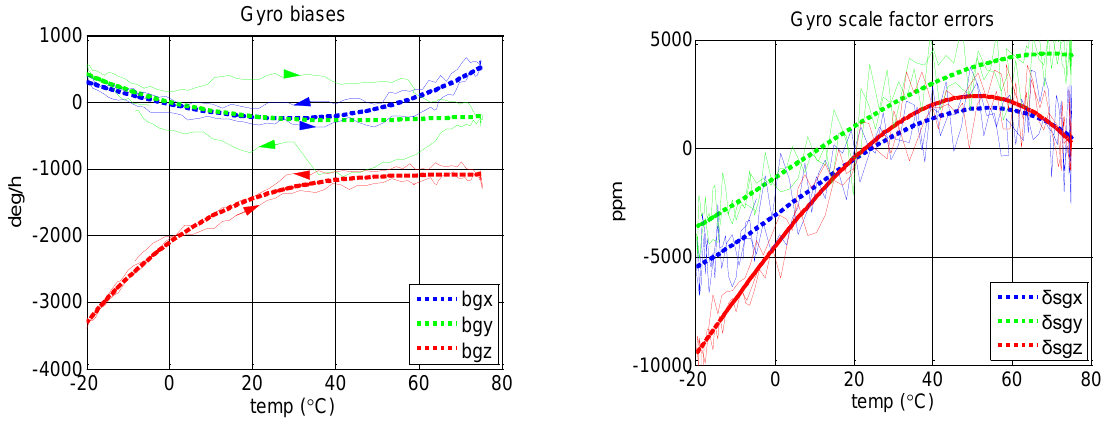
Figure 7. Thermal calibration results of MTi-G gyro biases and scale factor errors with proposed method. The thin dashed lines show the raw calibration results ( i.e. , the result of each calibration scheme). Rightward and leftwards arrows indicate heating and cooling processes, respectively. The thick dashed lines are the final fitted results (3rd-order polynomial